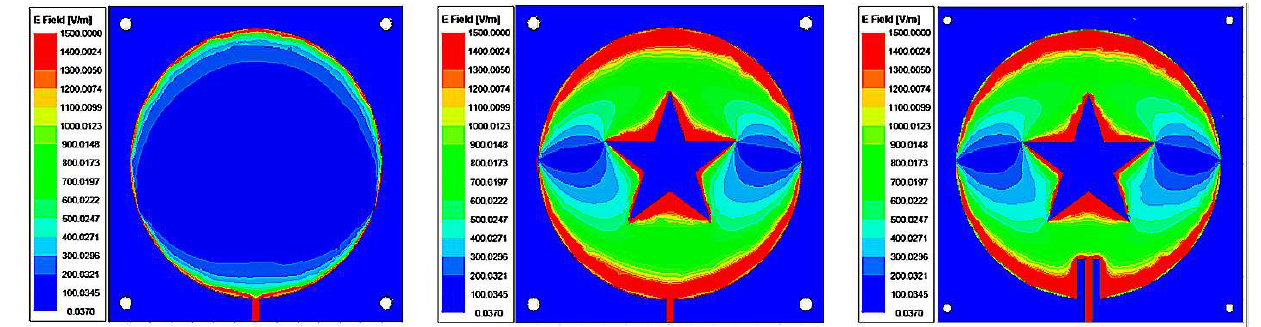
Figure 3. Comparison of the effect of slotted shape on the reflection coefficient of the sensor.